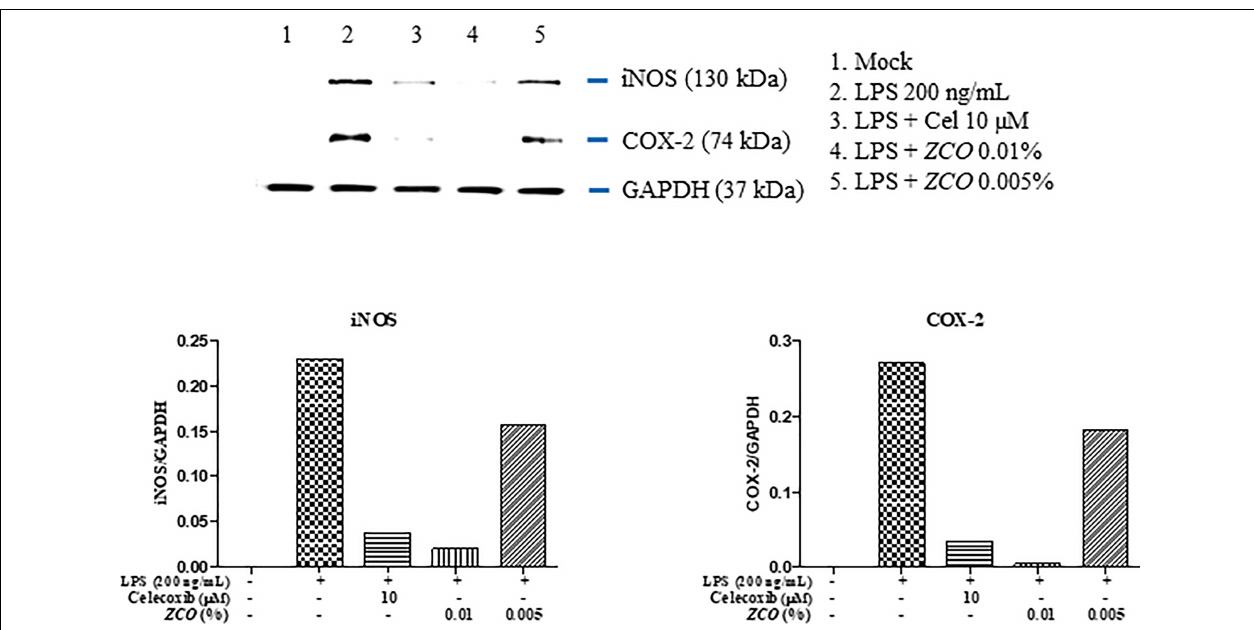
FIGURE 5 | Effect of ZCO on the expression of COX-2 and iNOS in LPS-activated RAW264.7 cells. RAW264.7 cells cultured into 6-well plate were pretreated with ZCO (0.01 and 0.005%) or celecoxib (10 µ M) for 2 h, and then LPS (200 ng/mL) was added to cells for 16 h. The protein levels of iNOS and COX-2 were detected by Western blot analysis. Celecoxib was used as a control for the COX-2 inhibitor, β -actin was used as the control protein.